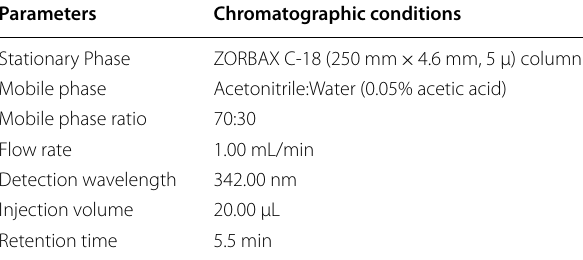
Table 3 Optimized chromatographic conditions